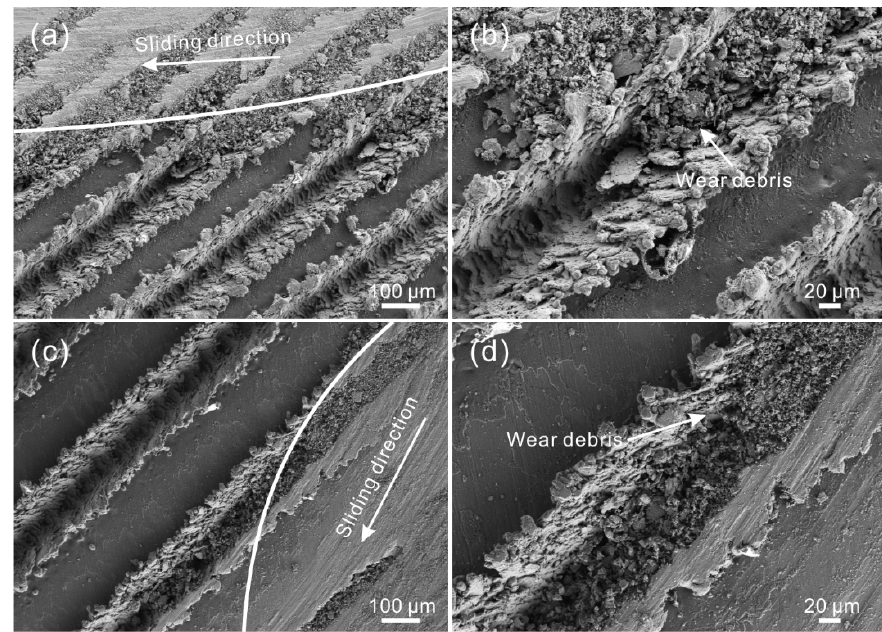
Figure 9. SEM image of the boundary of the worn surface of the LGS with texture spacing of ( a ) and ( b ) 150 μ m; ( c ) and ( d ) 250 μ m (load of 0.3 N, sliding speed of 400 mm/s, frictional pair of GCr15 bearing steel).